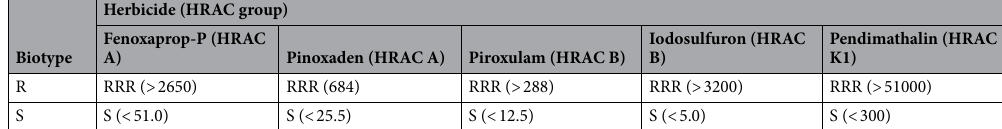
Table 5. Characteristics of herbicide multiresistant (BR) and herbicide-susceptible (S) biotypes of blackgrass used in the pot experiments. The numbers in brackets relate to the effective dose (g ha −1 ) of the active